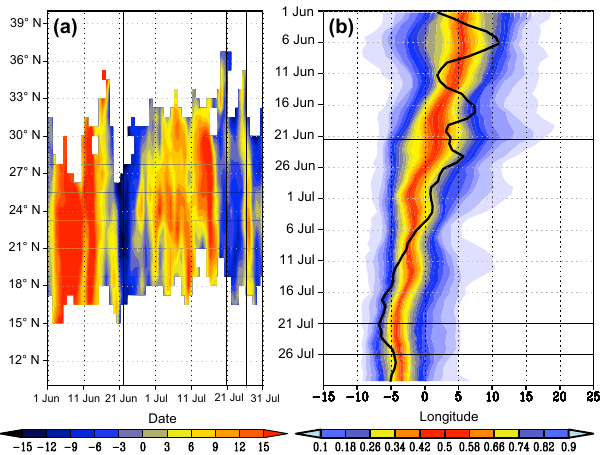
Figure 4. SHL evolution during June–July 2016. (a) Time–latitude anomalies of the SHL intensity (gpm) defined as the thickness be- tween 925 and 700hPa (relative to 1979–2016). (b) Longitudinal location of the SHL barycentre (black line) with the 1979–2016 percentiles in colour shading. See Sect. 2.2 for more details. The four phases of the DACCIWA campaign are marked with thin black